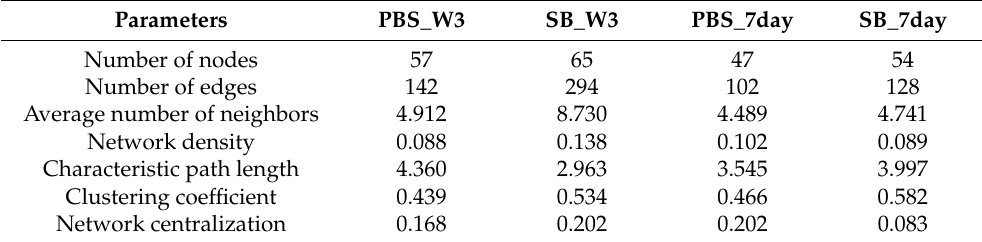
Figure 5. Effects of S. boulardii early intervention on microbial co-occurrence patterns. ( A ) Microbial co-occurrence networks of 4 groups. The size of each node is proportional to the degree of correla- tion. Phylum information for each node is presented in a different color. The edges represent the correlation between the two genera and the thickness of the edge represents the strength of the correlation, where orange represents a positive correlation and green represents a negative correla- tion. ( B ) Degree of co-occurrence networks for bacterial communities. ( C ) Clustering coefficient of co-occurrence networks for bacterial communities. ( D ) Neighborhood connectivity of co-occurrence networks for bacterial communities. Values are expressed as means ± SEM, *** p < 0.001. d, day. PBS, rats early intervened with phosphate buffer solution. SB, rats early intervened with S. boulardii . Table 3. The network property parameters. Table 3. The network property parameters.